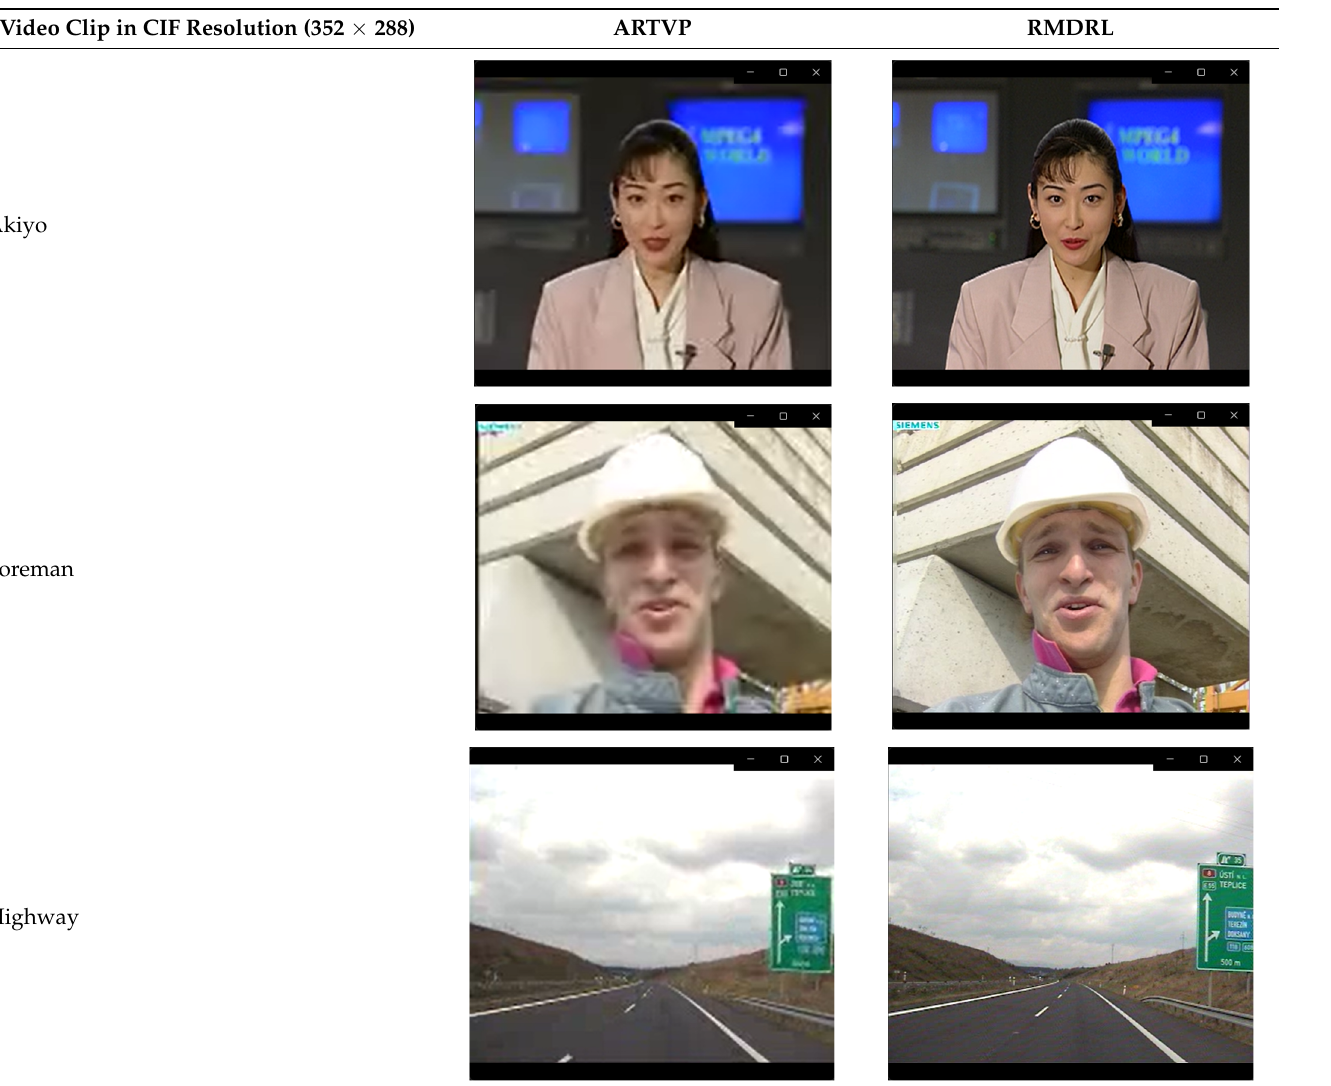
Table 3. Sample output of video frames containing artefacts for ARTVP and RMDRL.